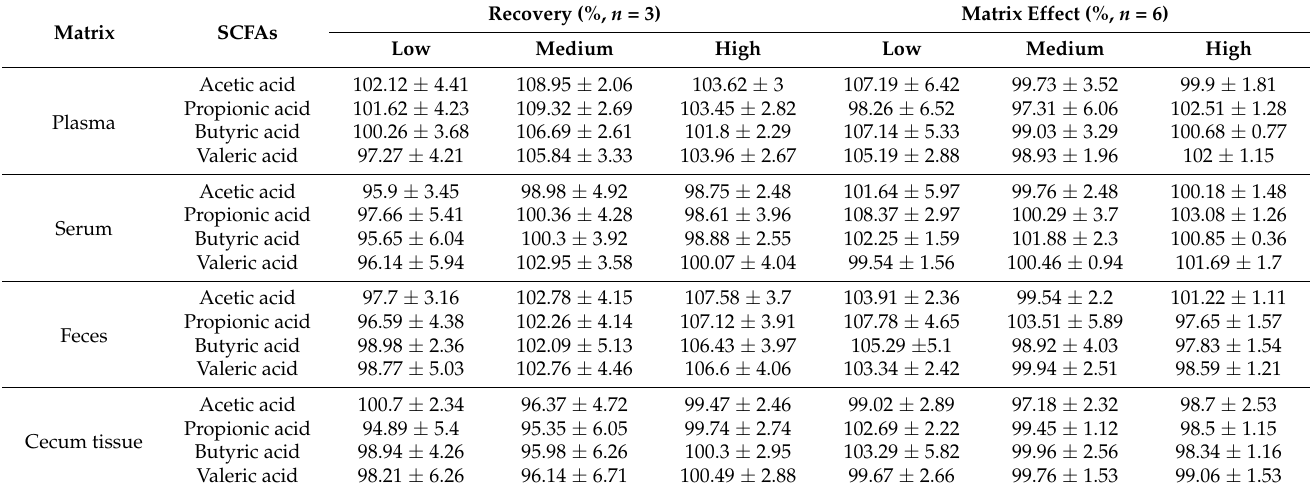
Table 4. Recovery and matrix effect values evaluated at three concentration levels. Presented values are mean ± standard